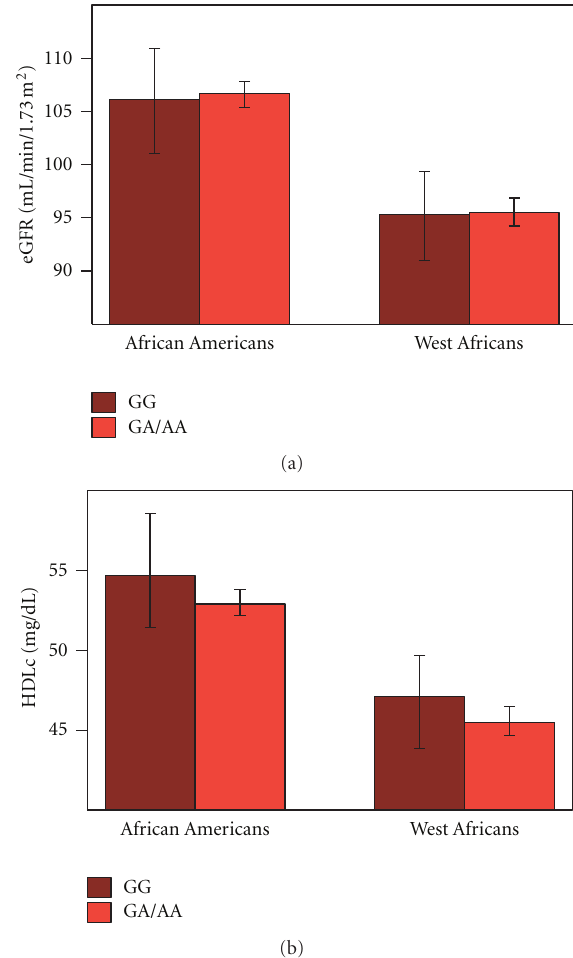
Figure 2: Mean HDLc and eGFR by rs73885319 Genotype among African Americans and West AfricansMean HDLc and eGFR by rs73885319 genotype (GG = nephropathy risk genotype), as estimated from linear mixed e ff ect models adjusting for age, age 2 , sex, and overall proportion of admixture (African Americans only), with random clustering for family. There were no statistically significant di ff erences in HDLc or eGFR by genotype.